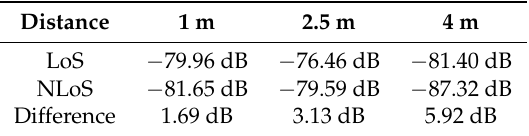
Table 7. RSSI values with LoS and no-line-of-sight (NLoS)